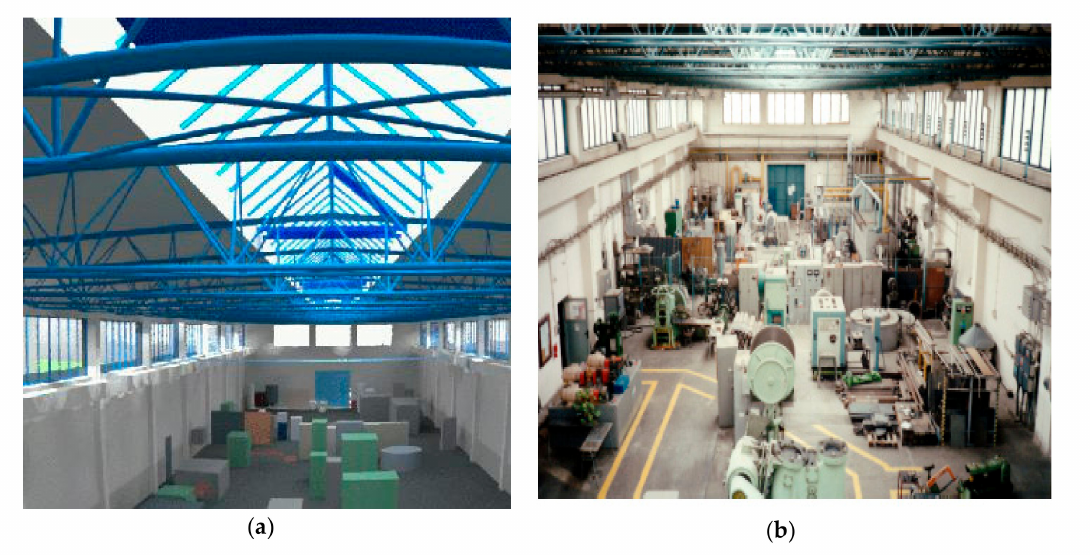
Figure 2. Internal view of the building: ( a ) model of the hall; ( b ) view of the